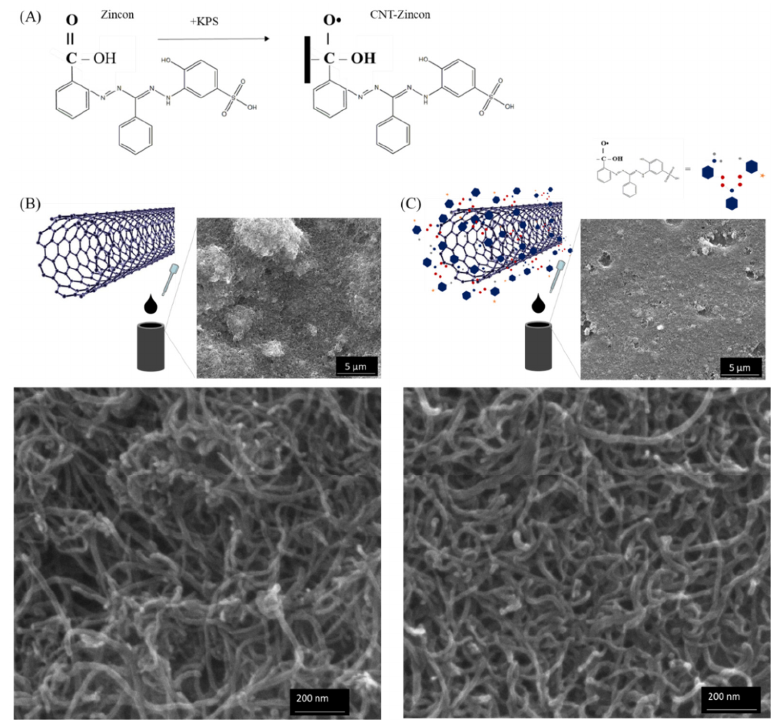
Figure 1. ( A ) Suggested mechanism of covalent grafting facilitated by KPS and, schematic of ( B ) CNT and ( C ) zincon-modified CNT followed by SEM images (low and high magnitude), where hexagon, gray dots, blue dots, red dots, and star represent aromatic group, oxygen element, carbon element, nitrogen element and Sulfonic acid, respectively. The successful grafting of zincon on CNT was confirmed by FT-IR (Figure 2A) and cyclic voltammetry (CV) (Figure 2B). The FT-IR spectrum of zincon-modified CNT (Figure 2A) showed, as expected, additional peaks compared to pristine CNTs at ~1660 cm − 1 and at ~1530 cm − 1 are attributed to C=N stretching and N=N stretching, respectively. The peaks at ~1500 cm − 1 and ~1350 cm − 1 are due to the benzene ring vibration of the zincon [40,56,57]. The broad band in the region at ~1250 cm − 1 to 750 cm − 1 could be attributed to the stretching of C–C and C–O in the carbon after the treatment with concentrated hydrochloric acid for 12 h [56]. It should be noticed that the as-received CNTs were purified by the manufac- turer and partial oxidation during purification by the manufacturer can result in the pres- ence of groups on the surface of pristine carbon nanotube. The peak ~3700 cm − 1 , for both CNT and zincon-modified CNT, could be related to the absorption of water molecules as a result of an O-H stretching mode of hydroxyl groups [47,56]. The peaks at ~2670 cm − 1 , 2320 cm − 1 , 2097 cm − 1 , and at 1990 cm − 1 could be attributed to the C=C asymmetric stretch- ing in graphite-like CNT structure [58]. The cyclic voltammogram of zincon-modified CNT (Figure 2B) clearly showed the reduction (~0 V and − 0.6 V vs. SCE) and oxidation ( − 0.4 V and ~0.1 V vs. SCE) peaks for zincon [43] and demonstrated a good stability after 10 cycles of CV (Figure 2C).